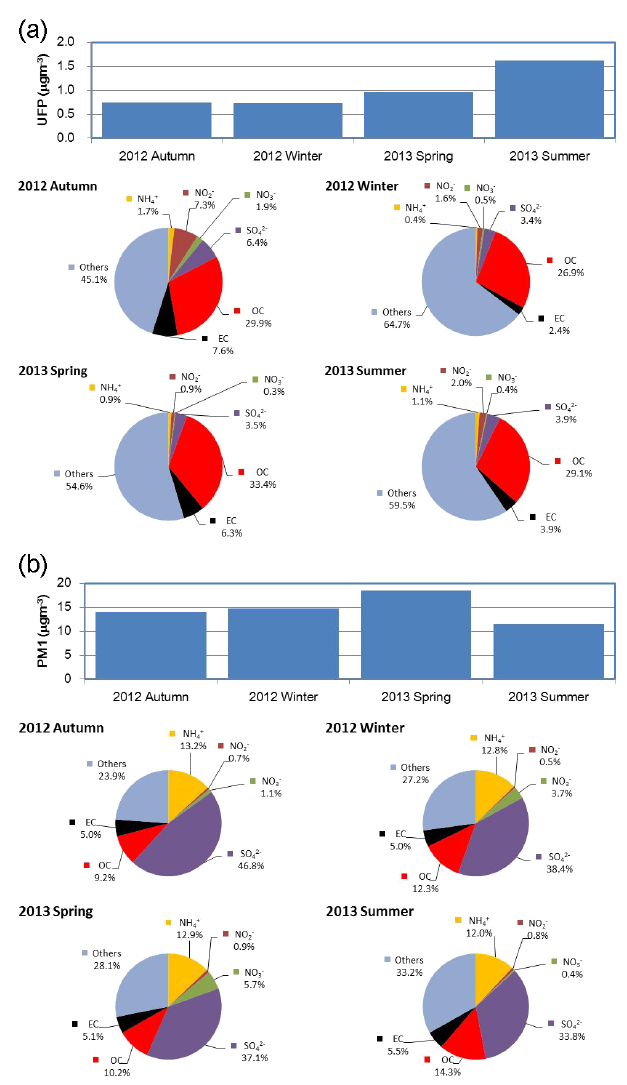
Figure 3. Seasonal average concentration and composition of (a) ultra-fine (UFPs) and (b) submicron (PM 1 ) particles observed at TARO in Taipei, Taiwan, from autumn 2012 to summer 2013.